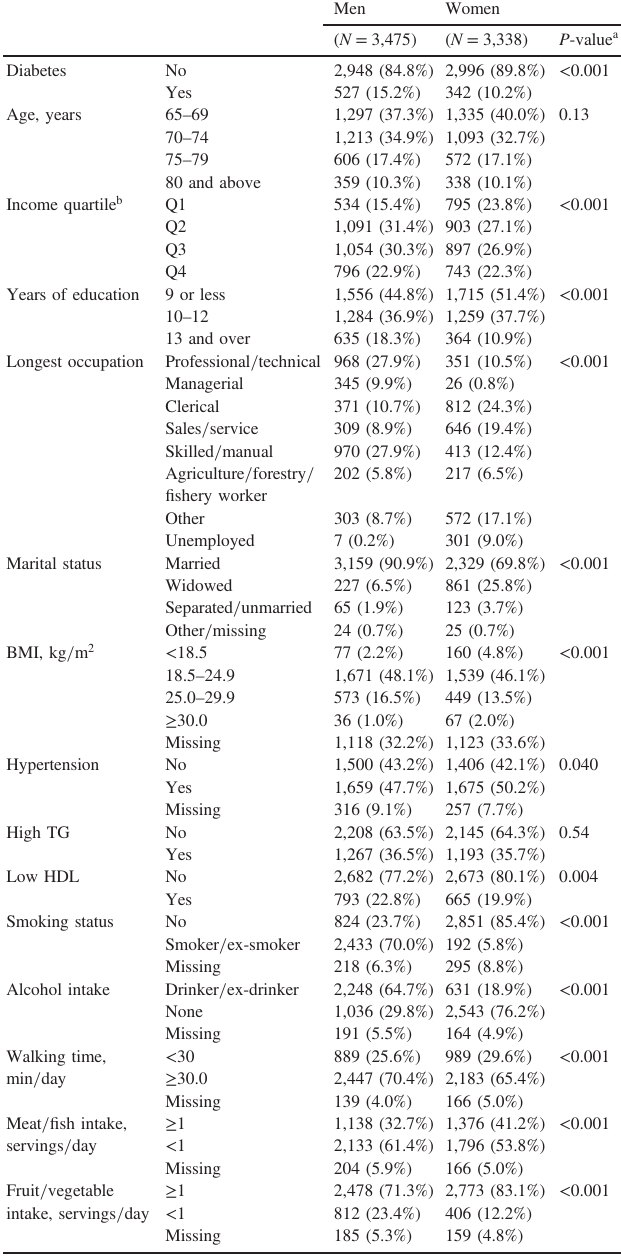
Table 1. Participant characteristics ( N =